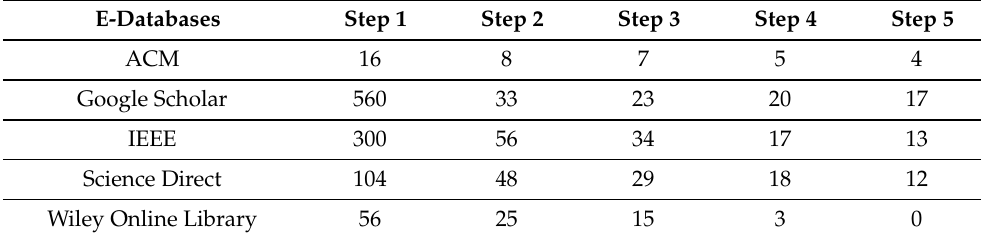
Figure 1. Methodology of articles inclusion and exclusion based on the tollgate approach. Table 1. Selection of articles based on tollgate